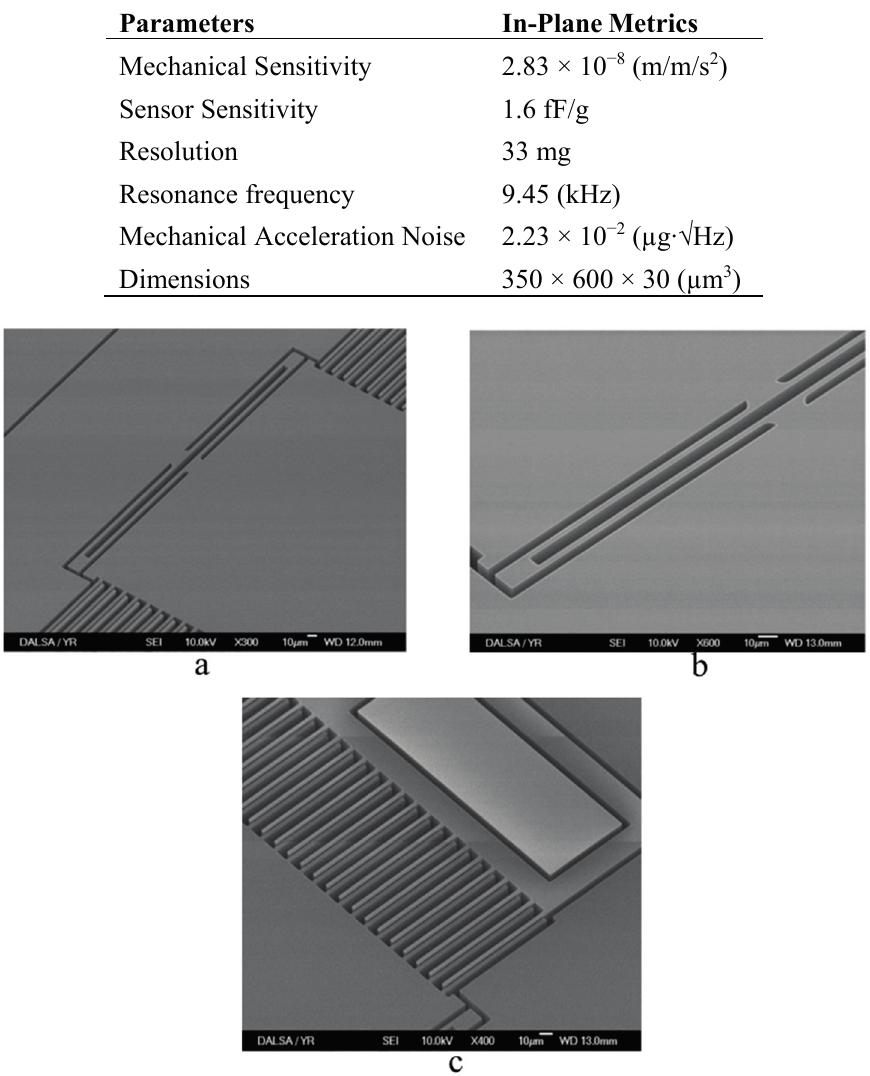
Figure 6. SEM images of the fabricated accelerometer device. ( a ) Accelerometer sensor; ( b ) U-shaped springs; ( c ) Inter-digitized sensing